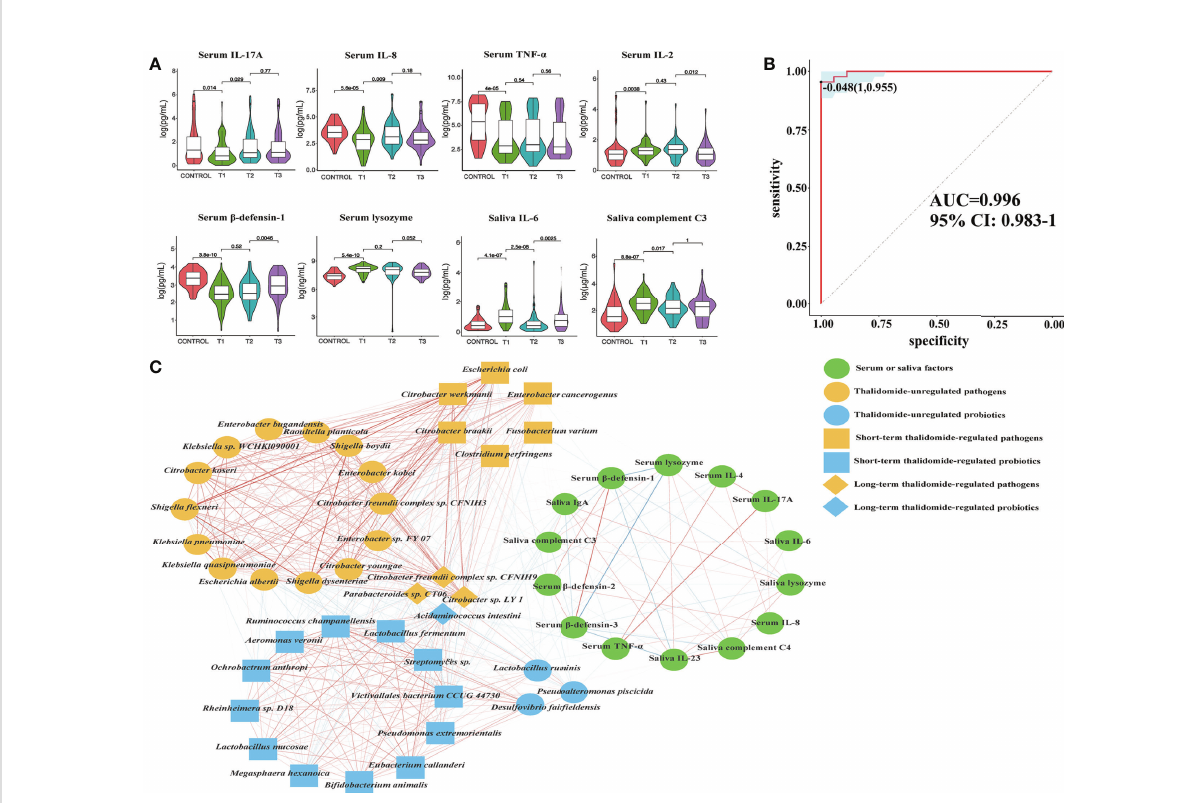
FIGURE 8 Contributional diversity of fecal microbiome cytokines. (A) Violin plot analysis comparing the levels of serous and salivary cytokines in control, T1, T2 and T3 groups ( P <0.05 between control and T1). (B) Receiver operating characteristic curves for fecal microbialcytokines comprising samples from RAU and healthy controls. “ 1 ” is the sensitivity of the optimal threshold point, and “ 0.955 ” is the speci fi city. “ -0.048 ” is the socre of adaboost modle at the optimal threshold point. The blue area 95% con fi dence represents the con fi dence interval. (C) Abundance-based species-cytokines correlation network enriched in RAU patients and healthy individuals. Two nodes are linked if they are related. The edge width is proportional to the correlation strength. Nodes with the different color and shapes are classi fi ed in the different effective order level with